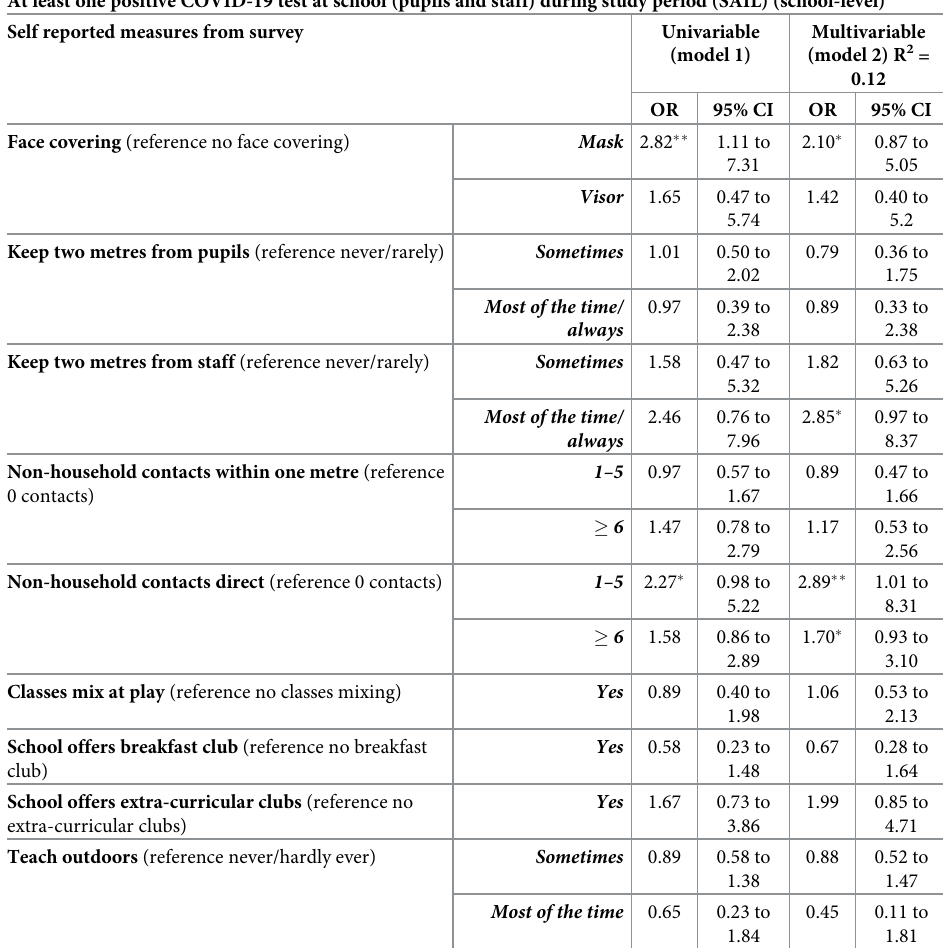
and a trend to higher general infection (Table 4, model 3). Reporting 6 or more contacts within 1-metre was associated with higher depression (OR = 2.70, Table 6, model 8). Face covering. In the univariable model there was evidence that reporting to wear a face covering was associated with an increased odds of a school-level COVID-19 case; OR = 2.82. Compared to reporting no face coverings, masks were associated with increased odds of reporting cold symptoms (multivariable model: OR = 1.98), Table 4, model 4). Reporting wearing a visor was associated with higher odds of depression (multivariable model: OR = 4.81, Table 6, model 8). Two metre distance from pupils or staff. In the univariable models there were no statis- tically significant results to support a reduced odds for any of the outcomes when using two metre distancing. In the multivariable models we found a trend to an increased odds of a